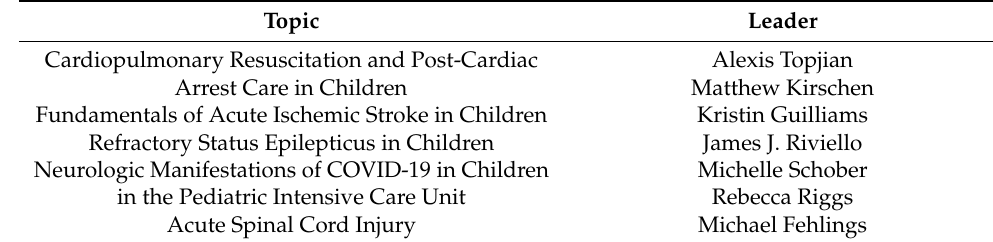
Table 1. Initial core topics as decided by expert consensus.